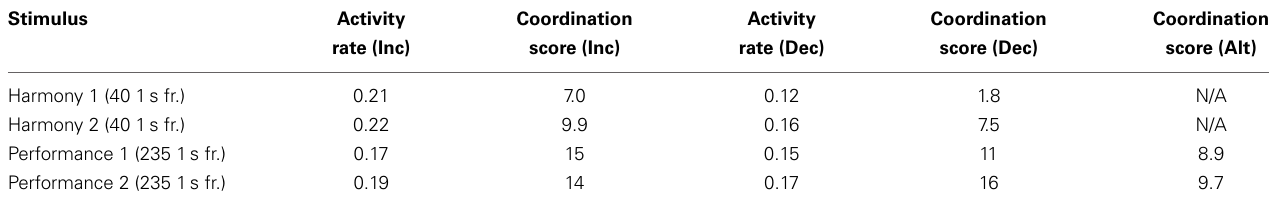
Table 1 | Tension-rating change activity and coordination for the first and second presentations of two stimuli, as measured in 1s time